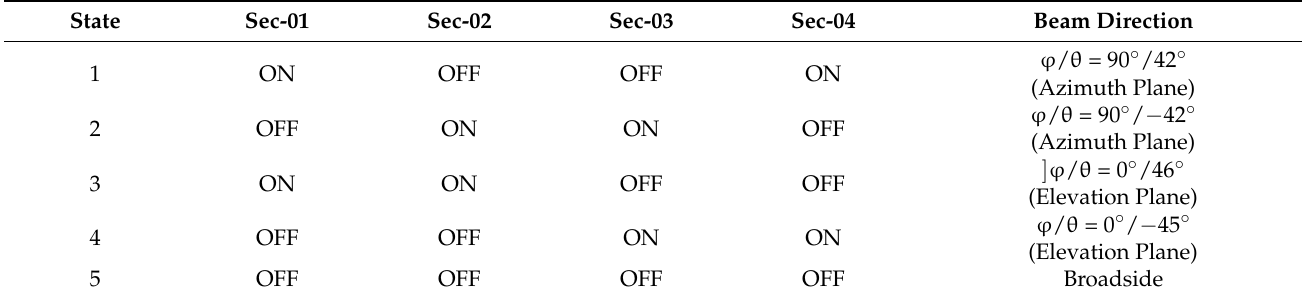
Figure 7. ( a ) Overall PRS structure having PRS placed at a height “H” from the antenna ( b ) The top- view of active partially reflective surface (PRS) ( c ) The bottom-view of the active partially reflective surface (PRS). Table 2. States and Beam Tilt of the Proposed Antenna.